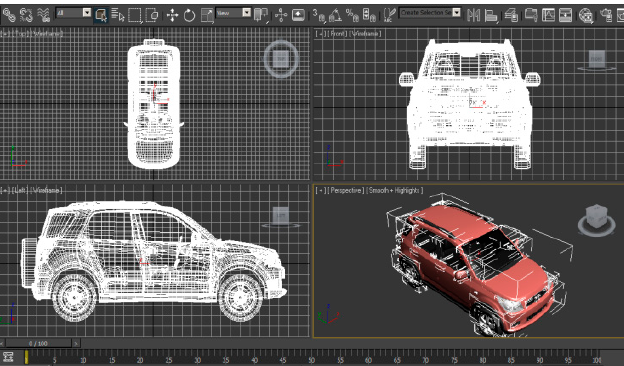
Figure 3. Model of a Small SUV for RCS calculation.